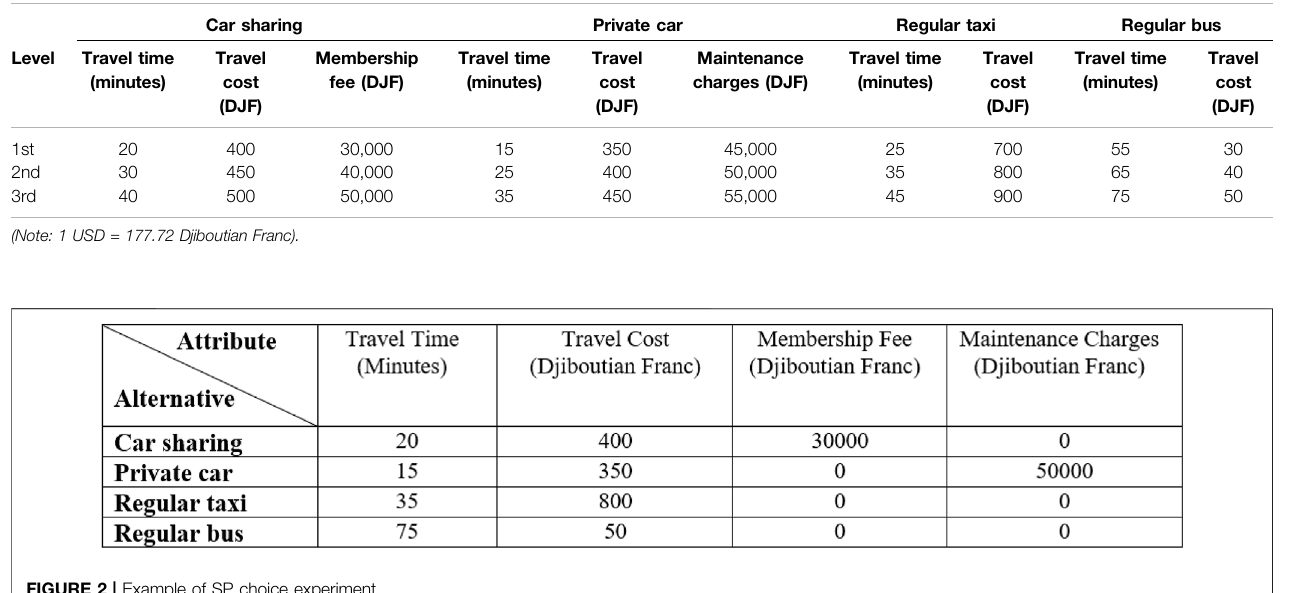
FIGURE 2 | Example of SP choice